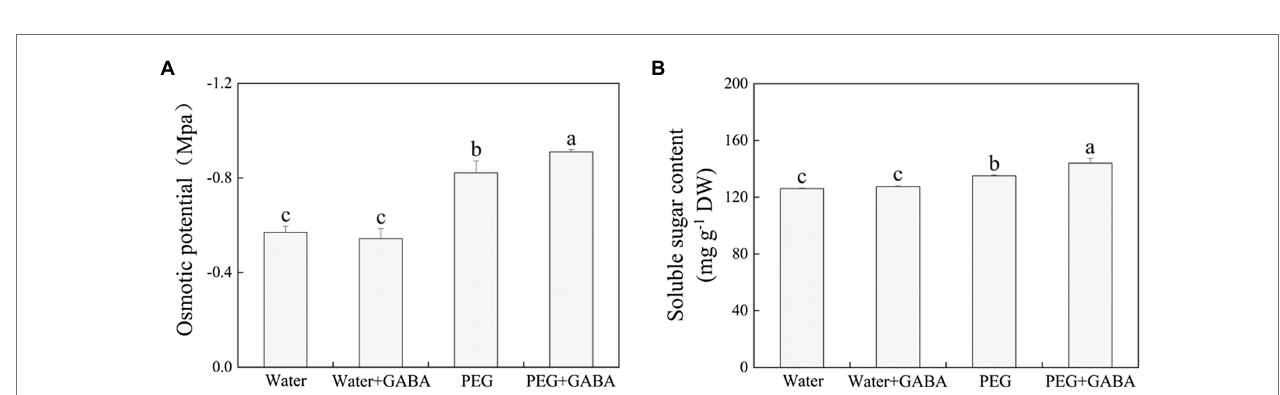
FIGURE 2 | Effects of seed priming with deionized water or γ -aminobutyric acid (GABA) on (A) phenotypic change, (B) endogenous GABA content, (C) root length, (D) seedlings dry weight, and (E) seedlings fresh weight on the 7th day of germination in white clover under water stress.